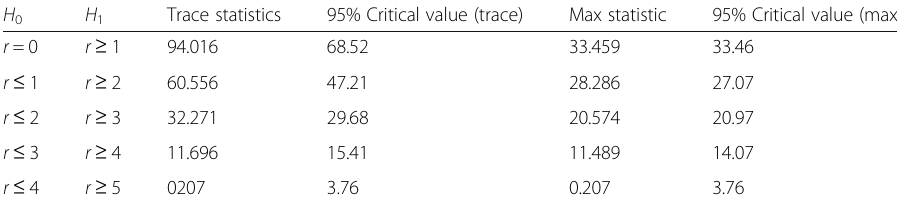
Table 4 Cointegration test results (with FDIG)